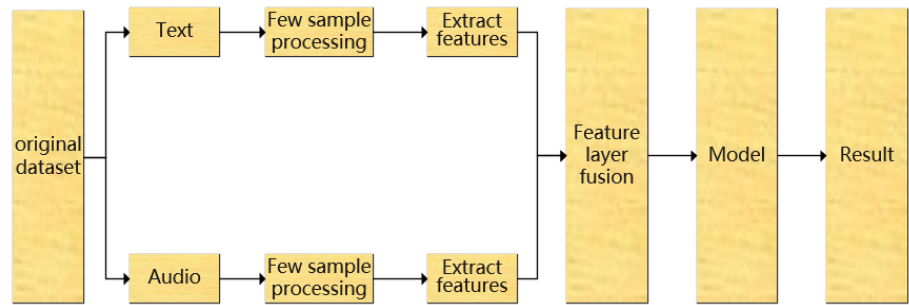
Figure 1. Feature Layer Fusion Scheme for Fewer Samples.